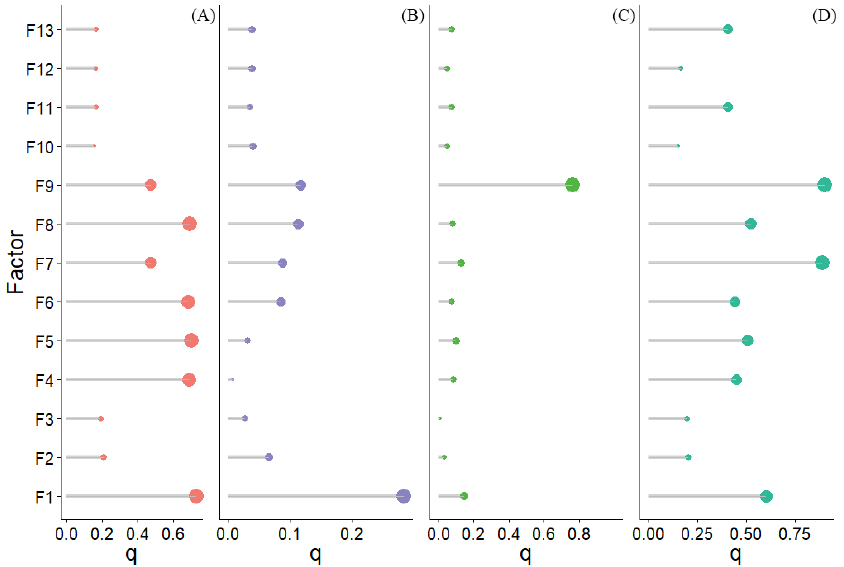
Figure 9. Plot displaying drivers of changes in types of mariculture including the ( A ) raft, ( B ) cage, ( C ) pond, and ( D ) mudflat.